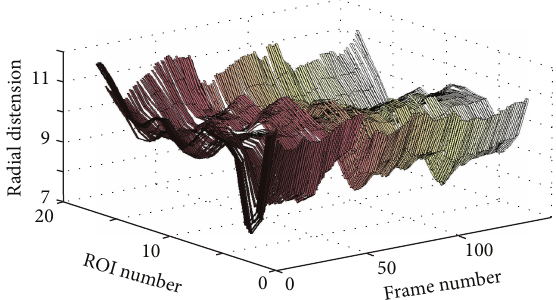
Figure 10: 3D plot showing the wave propagation along the vessel wall for the pathological case CAD2 (coronary case 2).